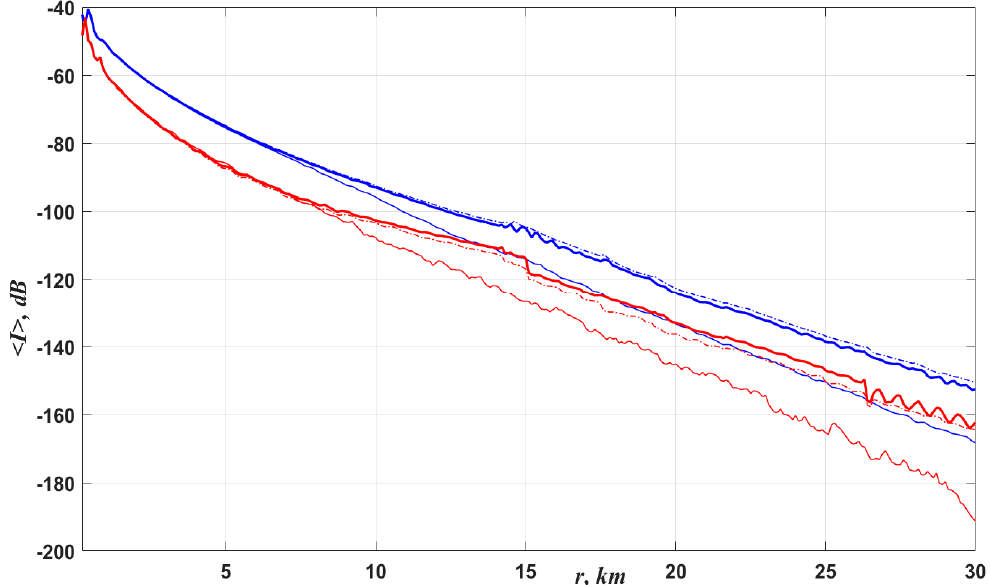
Figure 6. Transmission loss for a waveguide with Gaussian fluctuations ε and with non-Gaussian fluctuations in the form (14) with telegraph process ε 2 ( r ), L z = 20 m, L r = 4 km. Parameters of the bottom: c 1 = 1200 m/s, ( ρ 1 / ρ 0 ) = 1.5, β 1 = 0.01. H - z 0 = 42 m. Blue curves: H - z = 42 m; red curves: H - z = 26 m. Bold curves are the telegraph process ε 2 ( r ), dash curves are the adiabatic approximation, thin curves are similar to ones in Figure 4, correspond to Gaussian fluctuations.